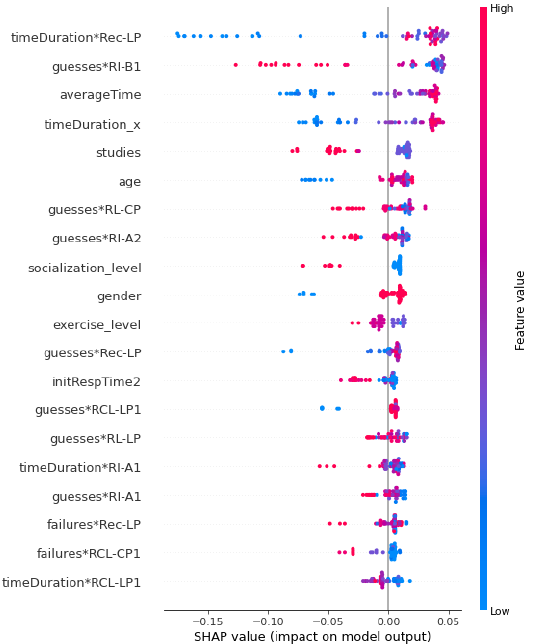
Figure 2. SHAP values indicating the relevance of features for participants with MCI (variables are ranked from higher to lower relevance; the horizontal axis shows whether the effect of the corresponding value is associated with a higher or lower prediction; colors shows whether variables’ original values were high (in pink) or low (in blue) for that observation).